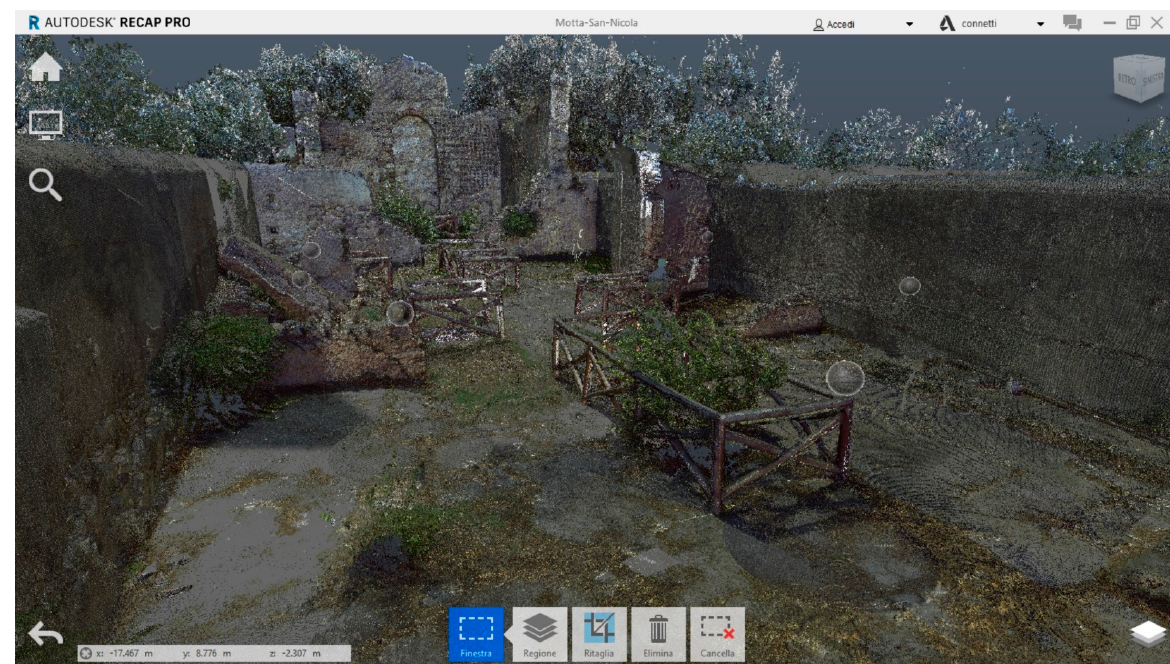
Figure 16. Dense cloud visualization in Autodesk ReCap.